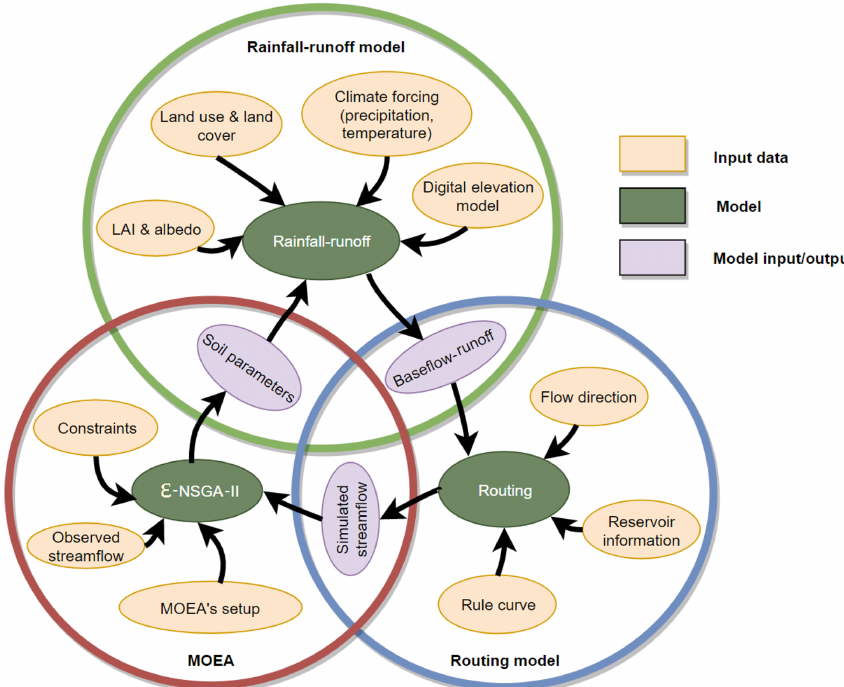
Figure 2. Computational framework adopted in the first part of this study. The framework consists of VIC’s rainfall–runoff and routing models and the MOEA ε -NSGA-II. The output of the rainfall–runoff model (i.e., gridded baseflow and runoff) is used by the routing model, which simulates the streamflow at multiple locations within the upper Mekong basin. The simulated streamflow is then used to calculate goodness-of-fit statistics, whose value is optimized with ε -NSGA-II by calibrating the parameters of the rainfall–runoff model. In other words, these parameters and goodness-of-fit statistics represent the decision variables and objective functions used by ε